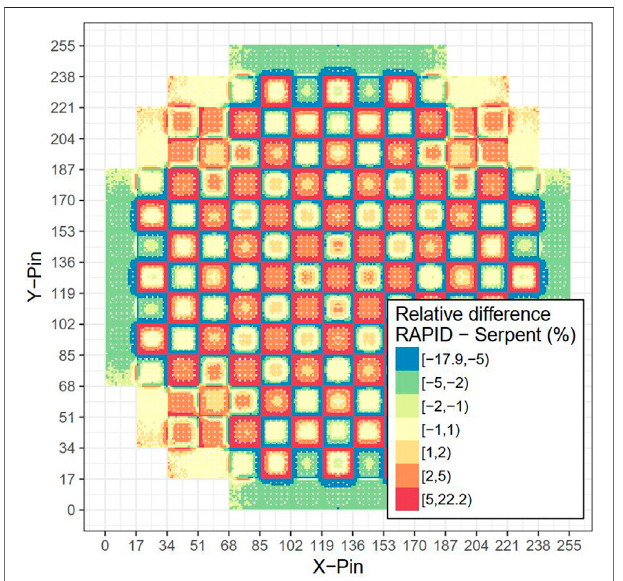
FIGURE 4 | The pin-wise relative error between the combined fi ssion matrix method and the Monte Carlo calculation.